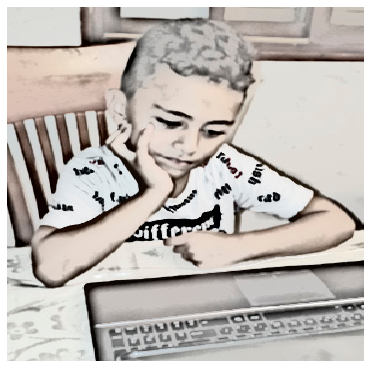
Figure 7. Ahmad (213) putting his hand on his head.